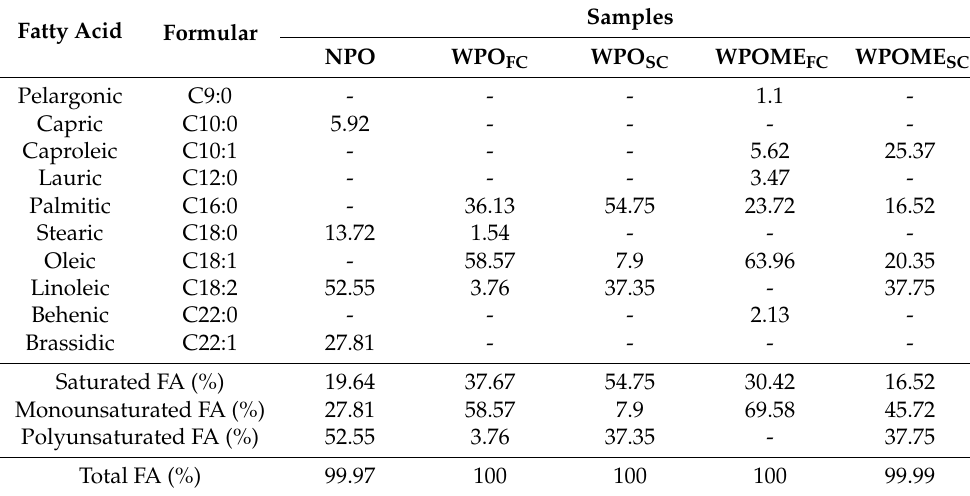
Table 5. FA composition of